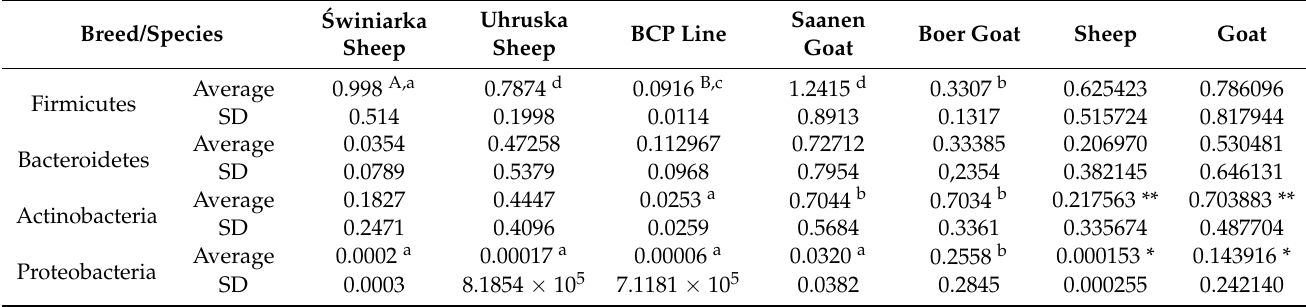
Table 3. DNA level ( ∆∆ Cq) of selected bacterial phyla on the skin of animals (a,b,c,d— p ≤ 0.05; A,B— p ≤